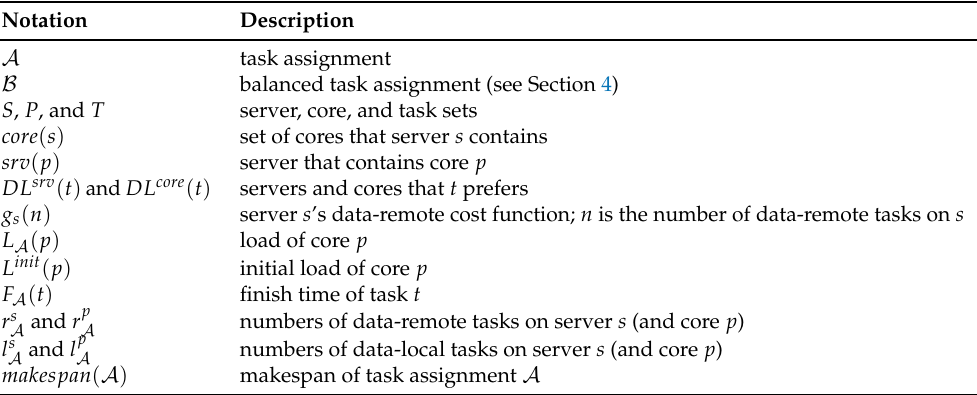
Table 1. Frequently used